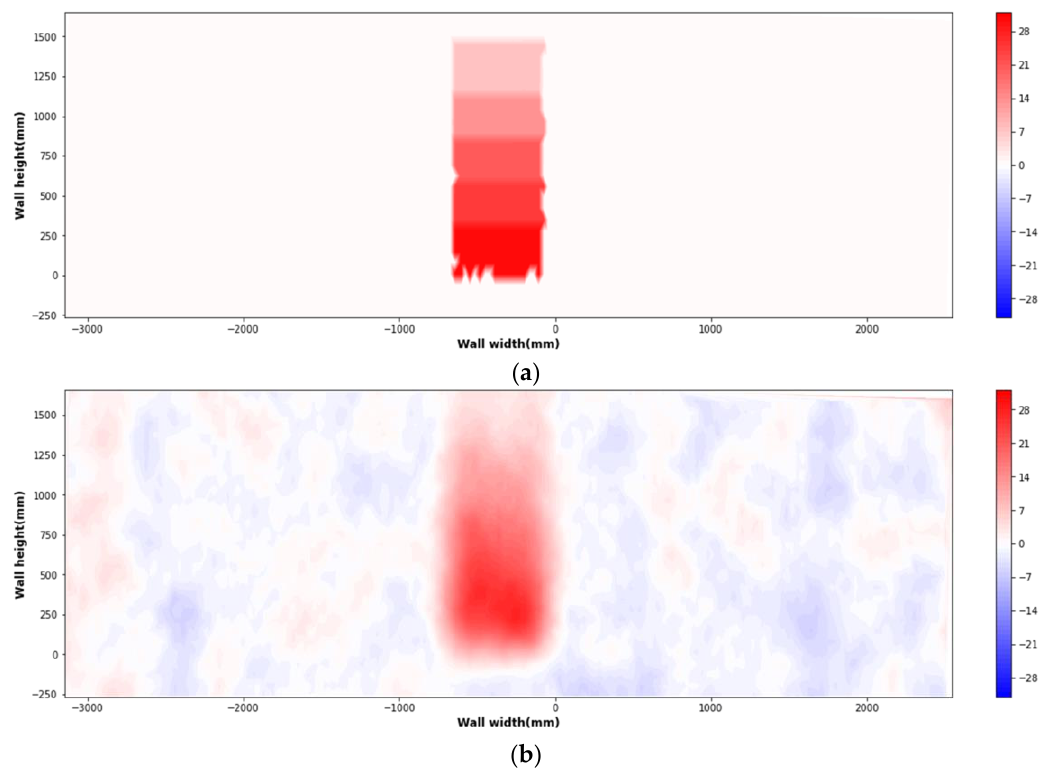
Figure 11. Distance analysis results obtained using the M3C2 algorithm. ( a ) Ground truth of lateral displacement; ( b ) predicted values of lateral displacement (RMSE: 2.82 mm).